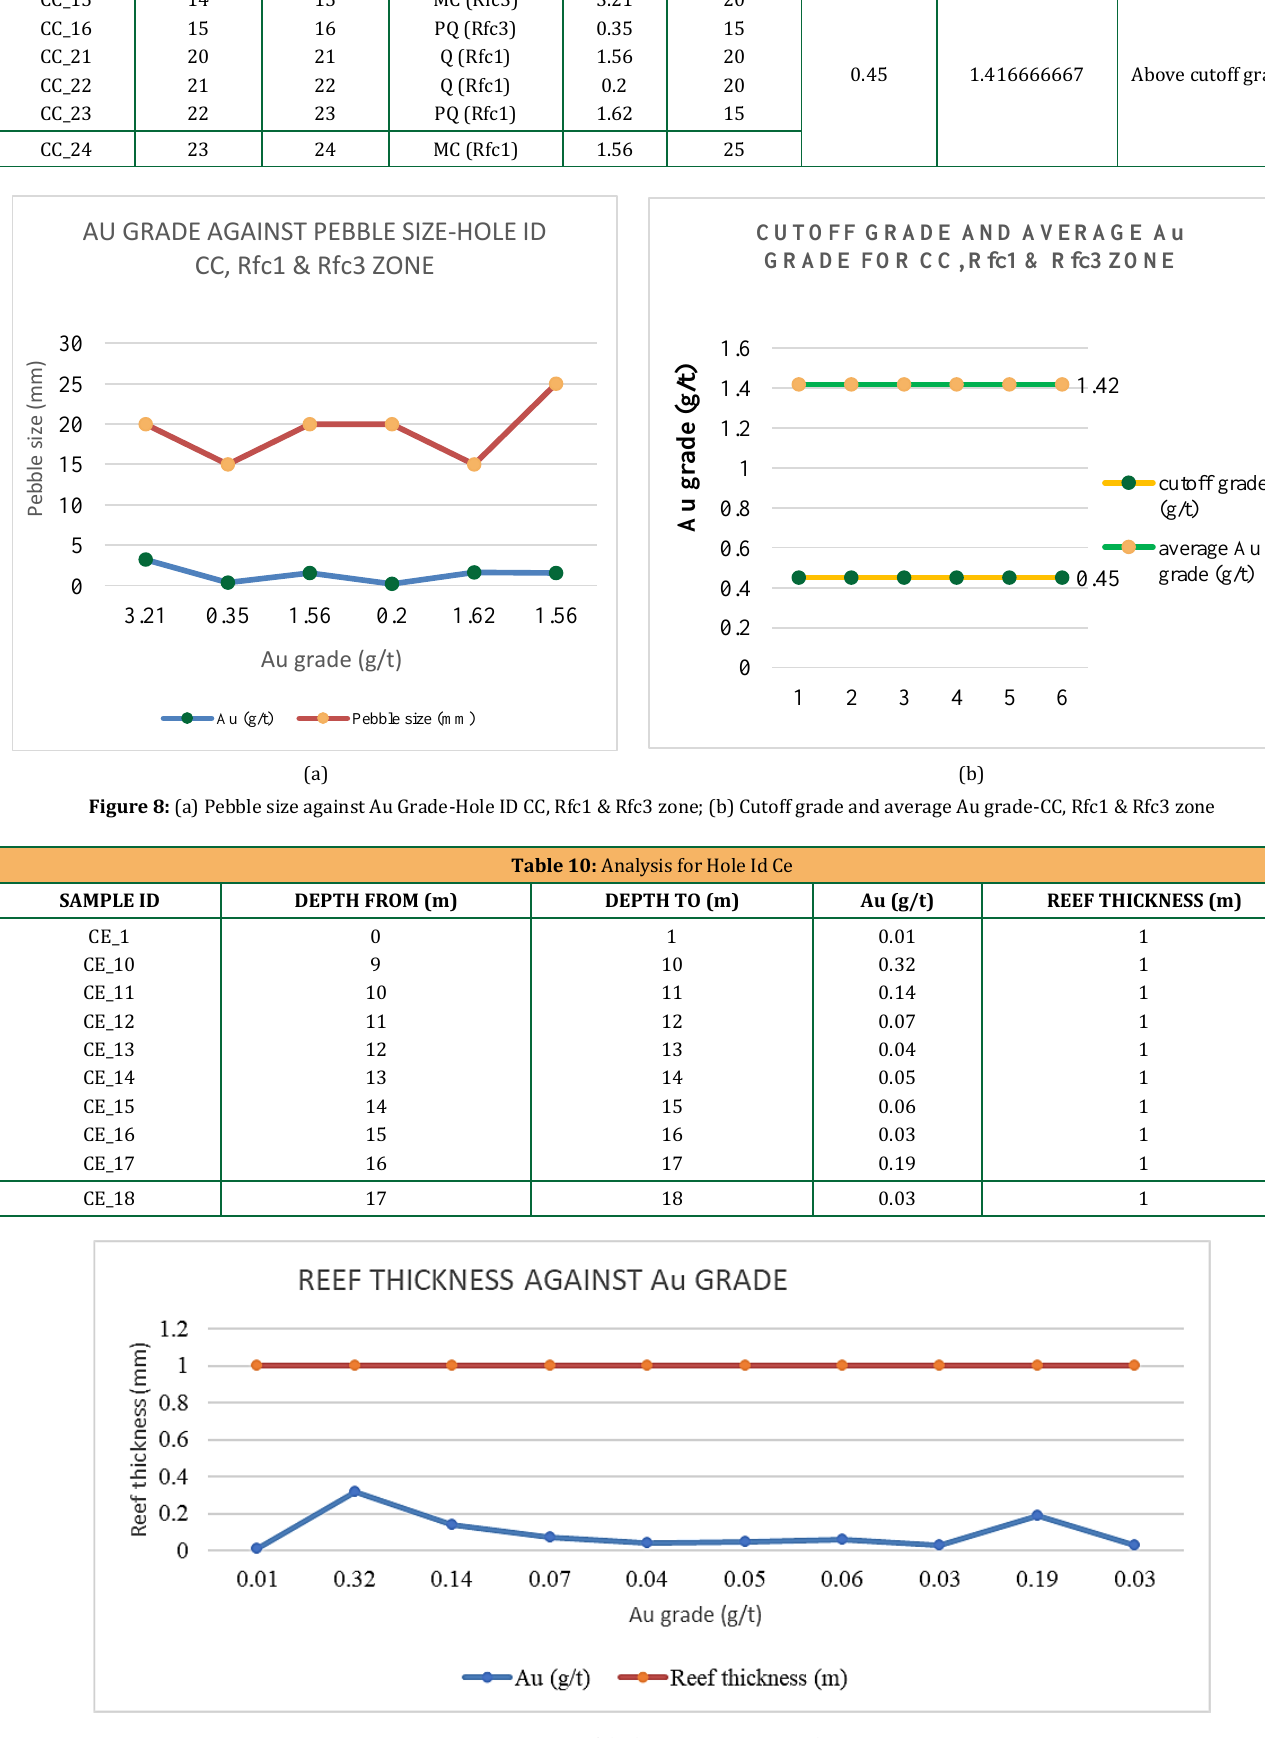
Figure 9: Reef thickness against Au